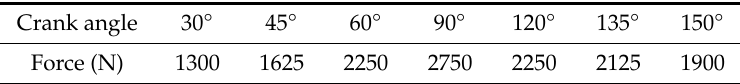
Table 1. Load distribution for topology